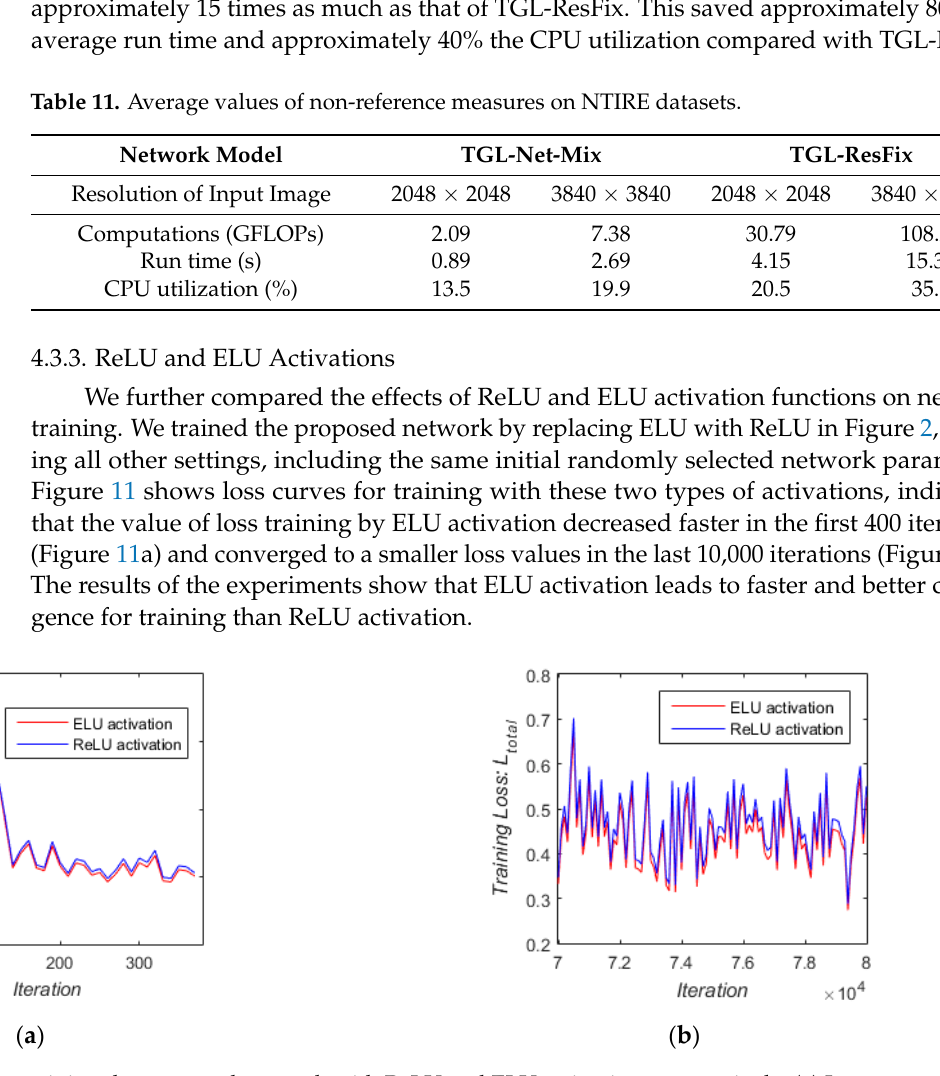
Figure 11. Loss curves for training the proposed network with ReLU and ELU activations, respectively. ( a ) Loss curve in iterations from 0 to 400; ( b ) loss curve in iterations from 7 × 10 4 to 8 × 10 4 .